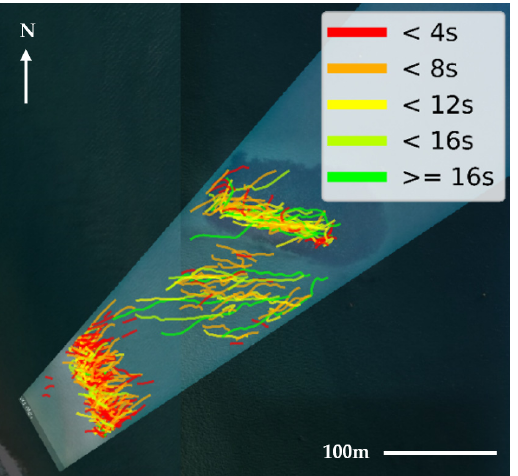
Figure 12. Durations maps for tracked rides between 8:30 am and 8:40 am at tide = 1.86 m LAT ( a ) and 12:10 pm and 12:20 pm at tide = 0.96 m LAT ( b ).